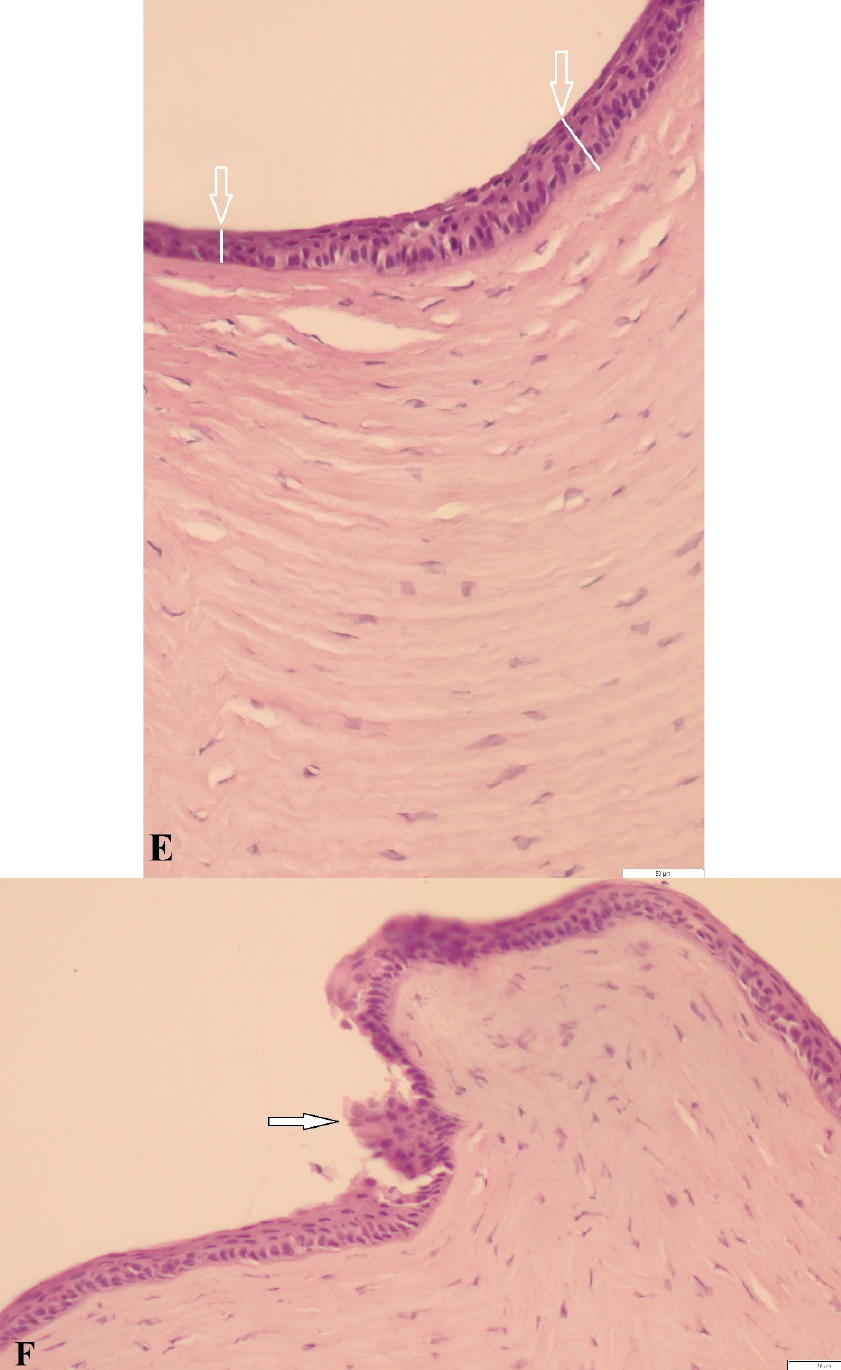
Figure 4. Microscopic examination of cornea in deep denaturation model. Examples of micrographs: ( A , B )—superficial damage to the corneal epithelium, ( C – F )—severe damage to the corneal epithe- lium. HE staining, magnification 200 × , ( A , D )—control, standard, homogeneous anterior corneal epithelium, the correct stroma of the cornea, normal, homogeneous. ( B )—ASC group, normal ep- ithelium, slightly thicker than in control. ( C )—Solcoseryl, regenerated epithelium, in places with a non-lumpy, slightly damaged surface (black arrow), focal detachment from the corneal essence (white arrows). ( E )—ASC group, normal epithelium, non-uniform thickness (white lines and white arrows), stable, normal corneal stroma. ( F )—Solcoseryl, epithelium with a visible defect (arrow), areas with a non-rough surface, the stroma of the cornea without